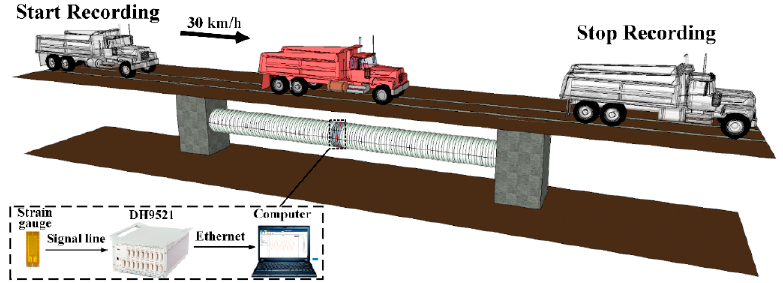
Figure 25. Tra ffi c load mode and strain data Figure 25. Traffic load mode and strain data collection. Figure 25. Traffic load mode and strain data collection.